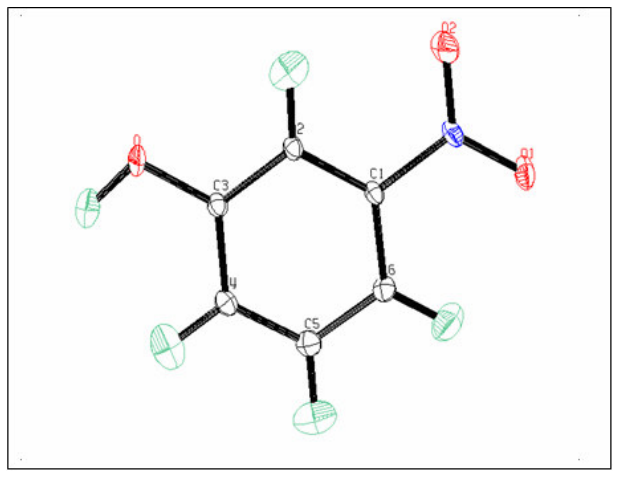
Figure 2 . ORTEPIII (Johnson, 1996) diagram of the m.Nitrophenol